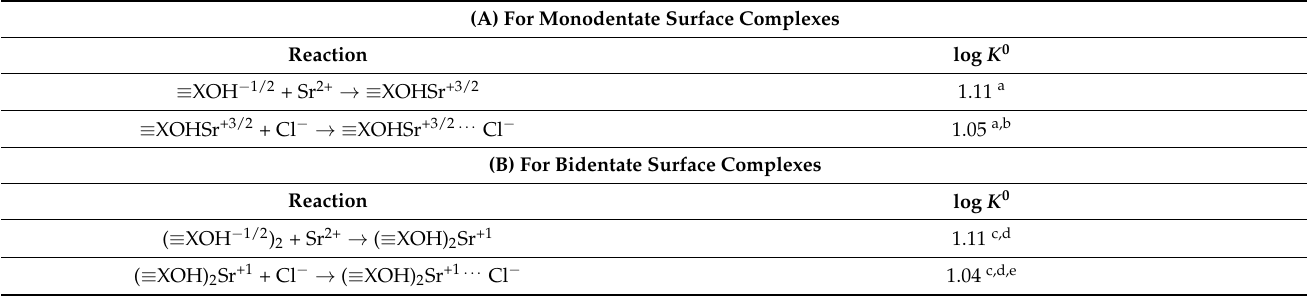
Table 2. Parameters and reactions used to model Sr adsorption onto the synthetic iron(III) oxide surface with an electrostatic SCM model at infinite dilution and zero surface potential. All parameters were